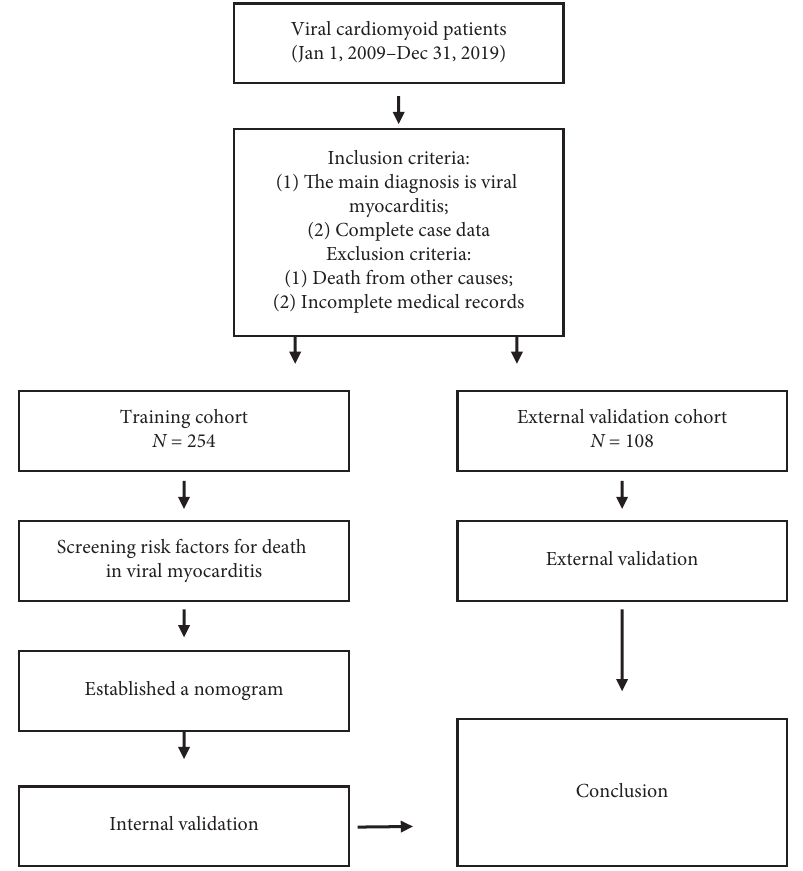
Figure 1: Research plan and implementation flow chart. Table 1: Demographic and clinical characteristics of all